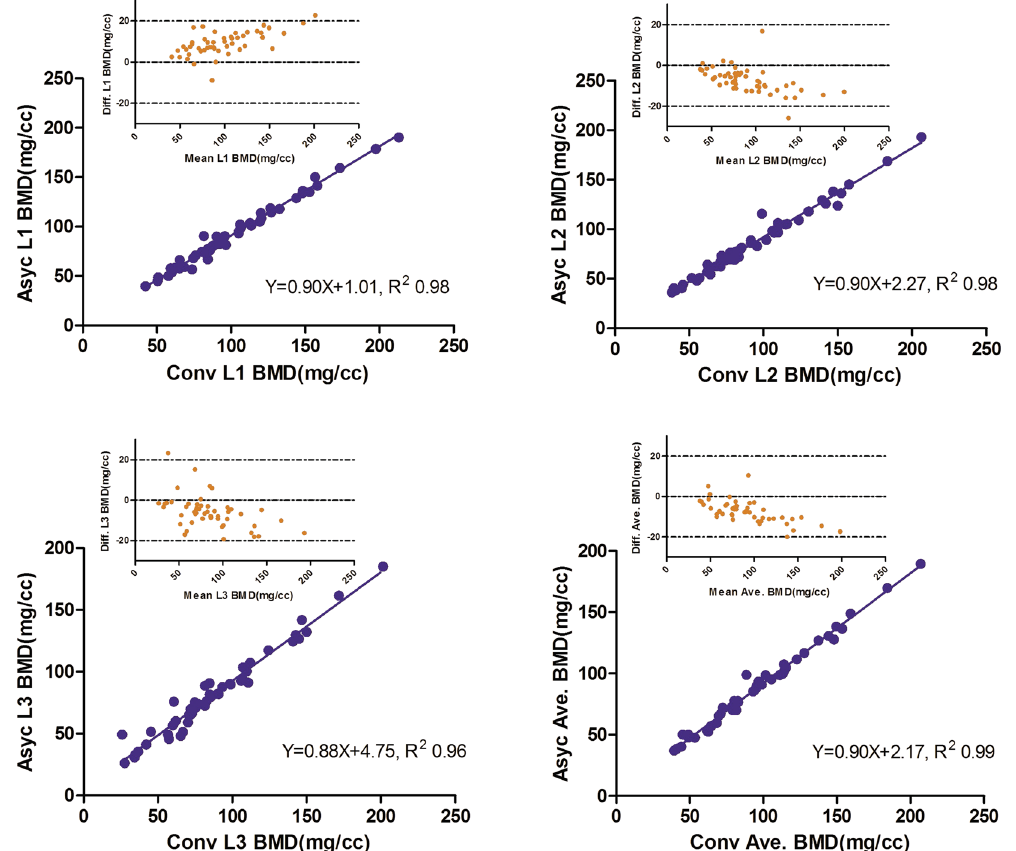
Figure 3. Correlation scatter plots for conventional and asynchronous quantitative computed tomography (QCT) outcomes of clinical subjects and Bland–Altman plots (small upper panel inserts) for conventional and asynchronous QCT BMD measurements of clinical subjects. Small upper inserts: Y-axis (Diff) is defined as (Asyc. − Conv.); X-axis is defined as the mean value of (Asyc. + Conv.).